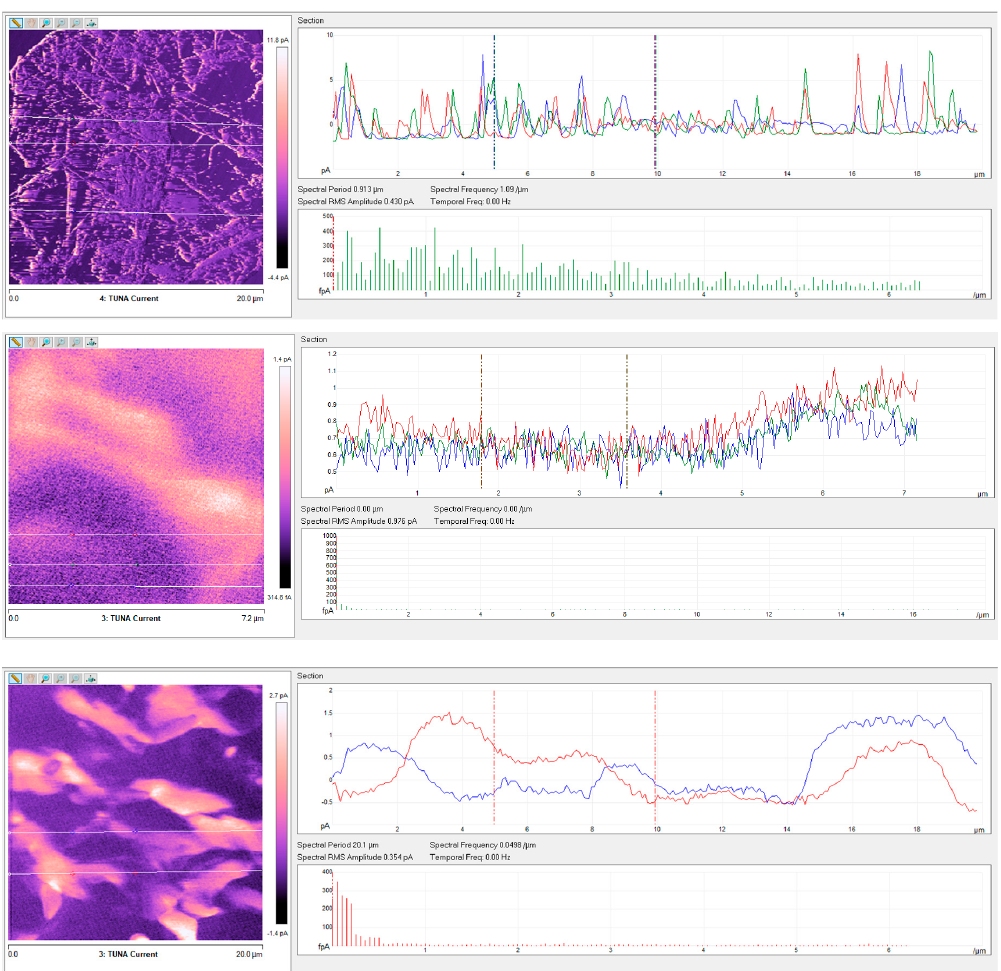
Figure 9. TUNA Current pictures (from left to right: 2D and 3D shapes) of the R1.8%G fracture surface.